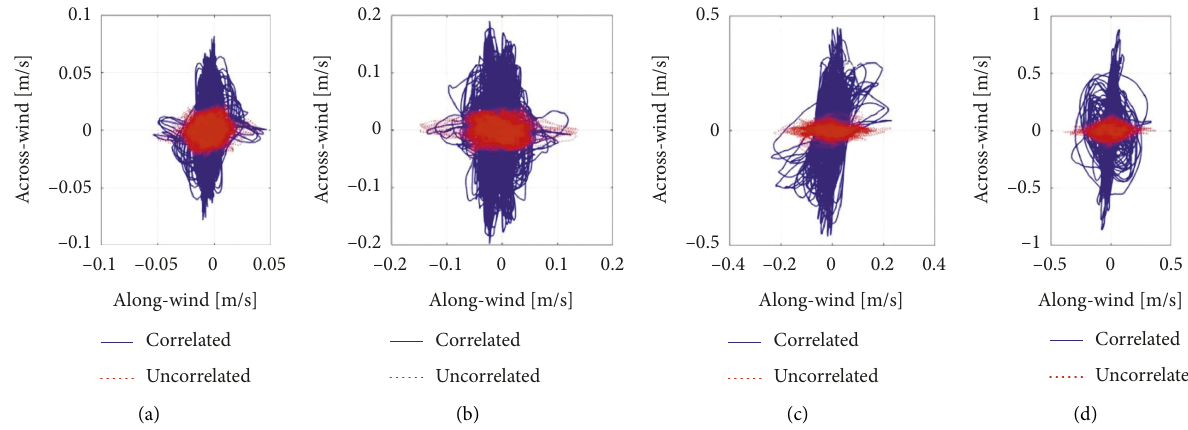
Figure 22: Rooftop velocities of the shear buildings in time domain. (a) H/ √ BD � 2, (b) H/ √ BD � 4. (c) H/ √ BD � 6. (d) H/ √ BD � 8.